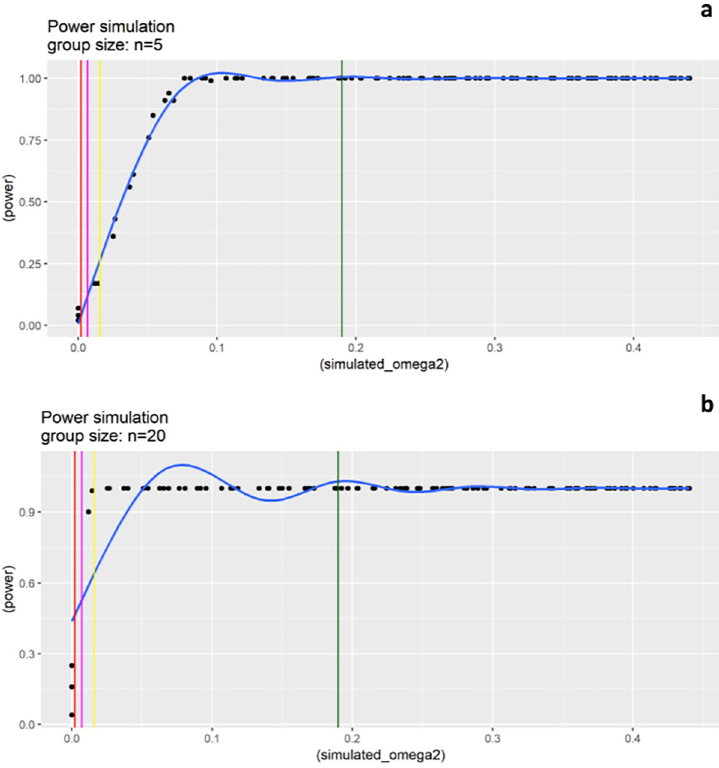
Fig 5. Power/Effect size (omega2) simulations with a sample size of n = 5 (a) and n = 20 (b) per group. The colored vertical lines represent the ω 2 values calculated on our experimental groups; dark green = Effect size for timepoint factor, yellow = Effect size for genotype factor at timepoint I, magenta = Effect size for genotype factor at timepoint III, red = Effect size for genotype factor at timepoint II.